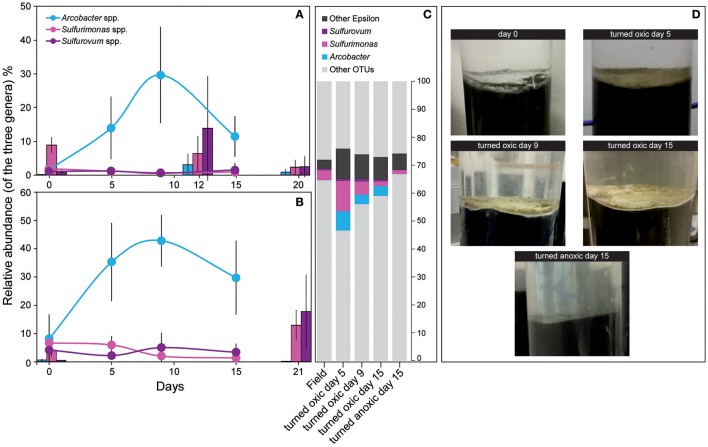
Relative abundance of the three dominant Epsilonproteobacteria genera from the field (day 0) and throughout the incubation experiment. (A) Shows 16S rRNA gene relative abundance in the water phase and (B) the top 1 cm sediment surface. (C) Shows the proportion (% FPKM) of the dominant Epsilonproteobacteria derived from metatranscriptomic reads assembled into RNA transcripts and annotated to genes linked to UniProtKB/Swiss-Prot reference organisms (proportion of FPKM). All samples consisted of biological triplicates (SD = 1) except sediment and water “turned oxic” day 15 (n = 4) and water “turned oxic” day 9 (n = 2). The gray areas denote other OTUs. (D) Shows photographs of sediment cores throughout the experiment for the “turned oxic” and “turned anoxic” treatments.